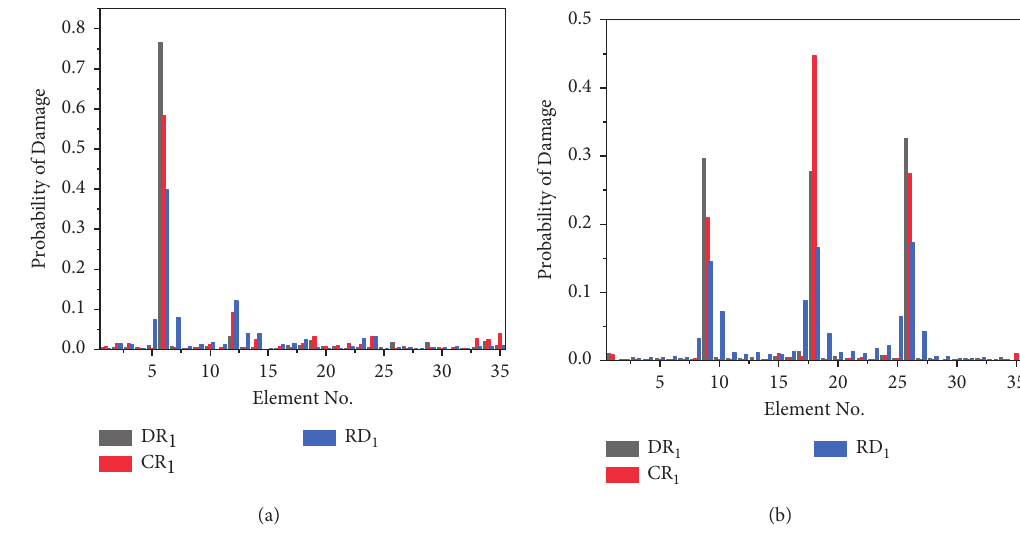
Figure 33: Recognition results of first-level fusion index for form 2 (a) and form 4 (b).